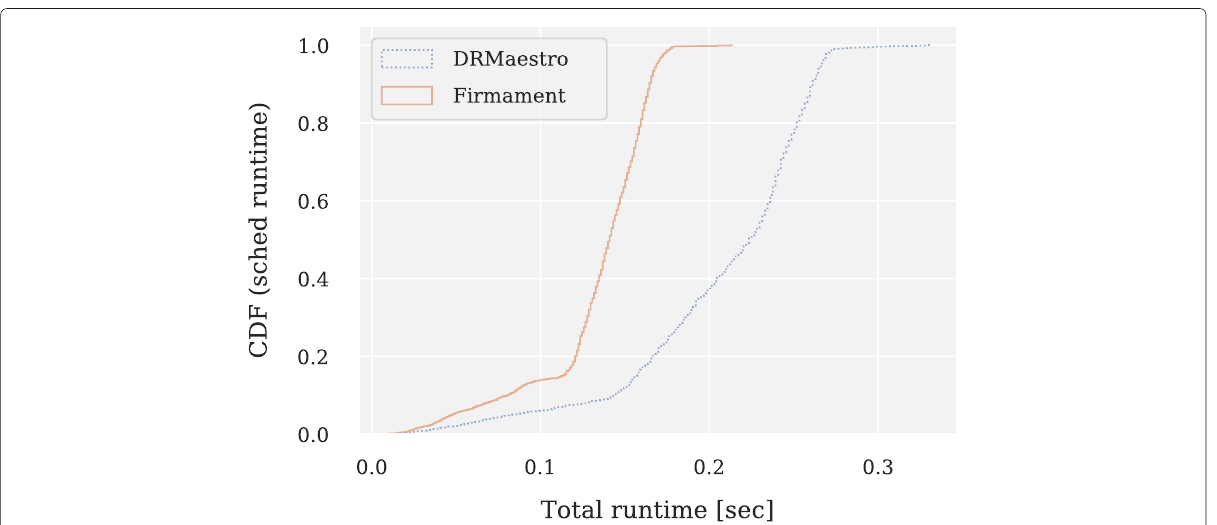
Fig. 6 Scheduler execution time. The DRMaestro scheduler runs 2 times slower than Firmament scheduler, since DRMaestro executes the model twice in two phases